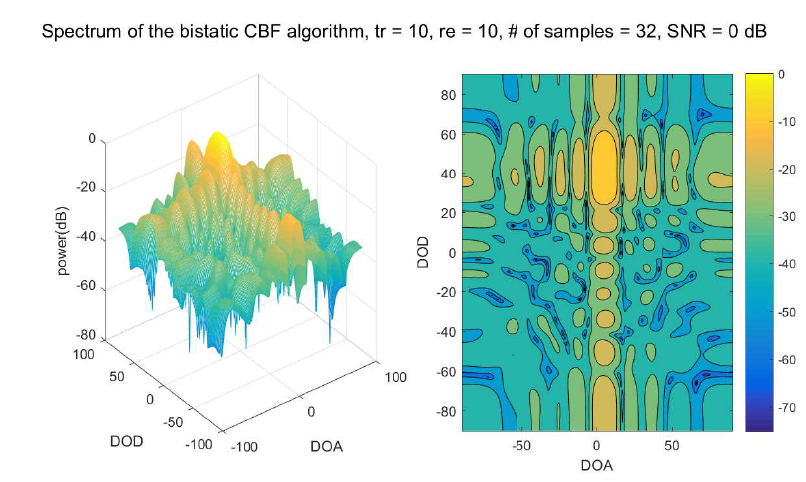
Figure 12. Spectrum of the bistatic conventional beamforming algorithm, SNR = 0